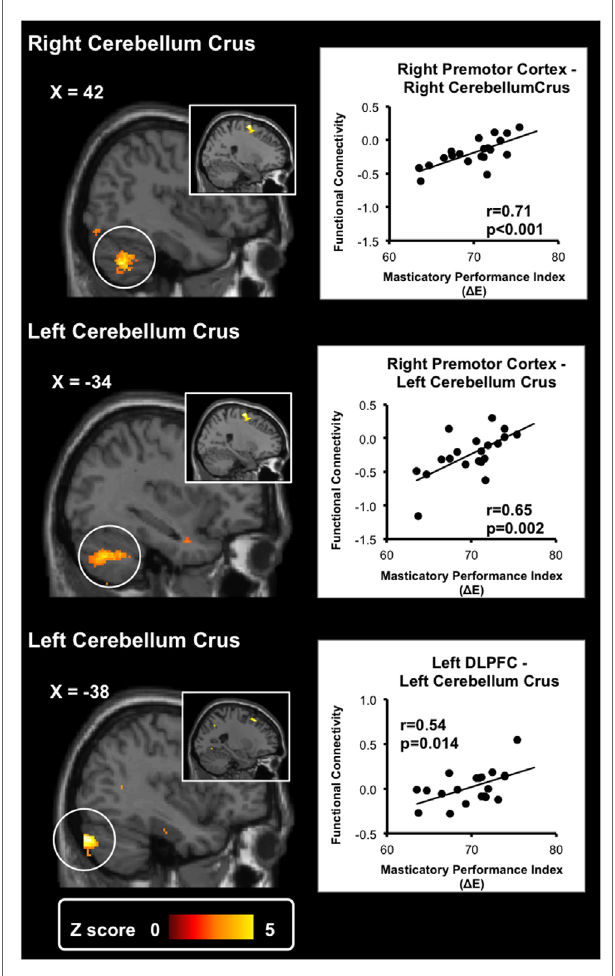
FigUre 2 | results of the seed-based functional connectivity analyses . Two seed regions, the right premotor cortex and the left dorsolateral prefrontal cortex (shown in the inlet pictures), were defined based on the results of the voxel-based morphometry. The whole-brain exploratory analysis revealed significant activation in the bilateral cerebellum crus. Resting-state functional connectivity between the seed regions and the cerebellum crus was significantly positively correlated with masticatory performance. The scatter plots show the association between the masticatory performance index ( Δ E) and the functional connectivity of each seed region. The functional connectivity was adjusted to remove the effects of age and